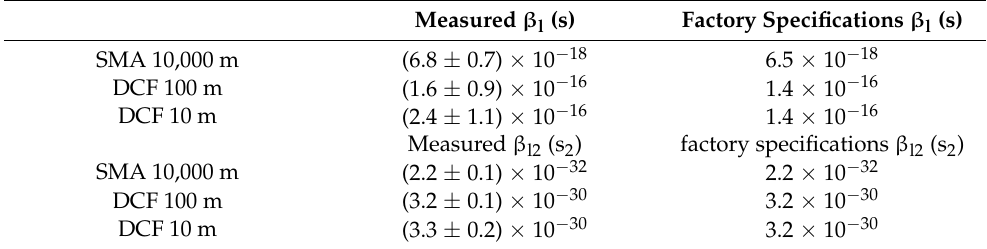
Table 1. Comparison of the experimental and factory